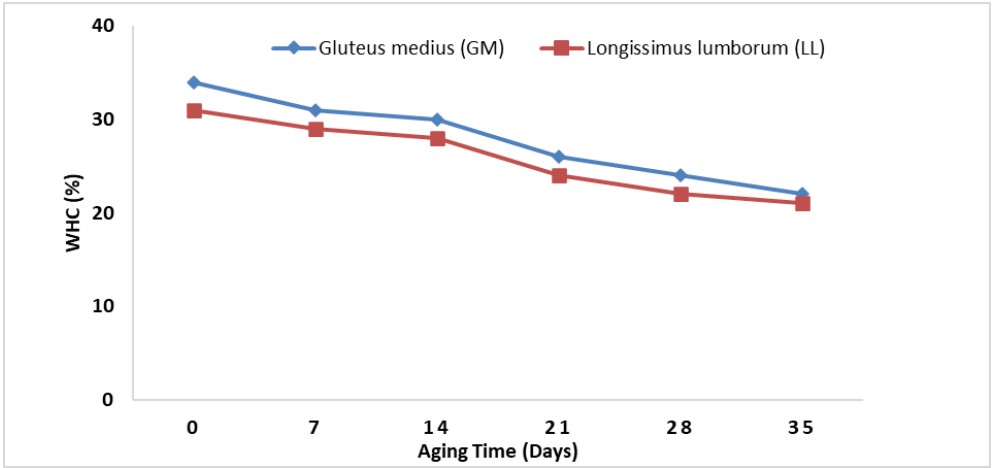
Figure 1. Effect of aging time on water holding capacity of two different muscles of buffalo meat.